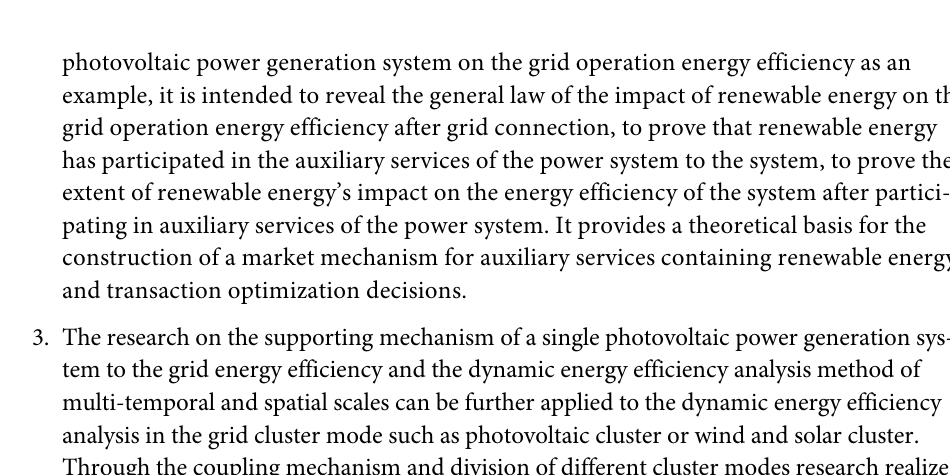
photovoltaic power generation system on the grid operation energy efficiency as an example, it is intended to reveal the general law of the impact of renewable energy on the grid operation energy efficiency after grid connection, to prove that renewable energy has participated in the auxiliary services of the power system to the system, to prove the extent of renewable energy’s impact on the energy efficiency of the system after partici- pating in auxiliary services of the power system. It provides a theoretical basis for the construction of a market mechanism for auxiliary services containing renewable energy